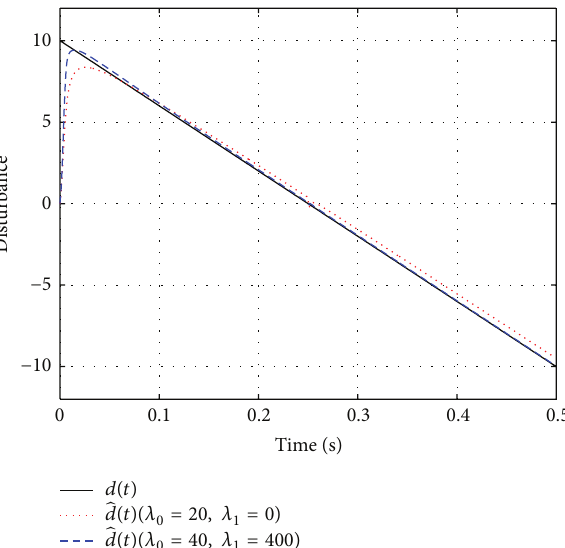
Figure 4: Results of Example 1 with different 𝑤 .